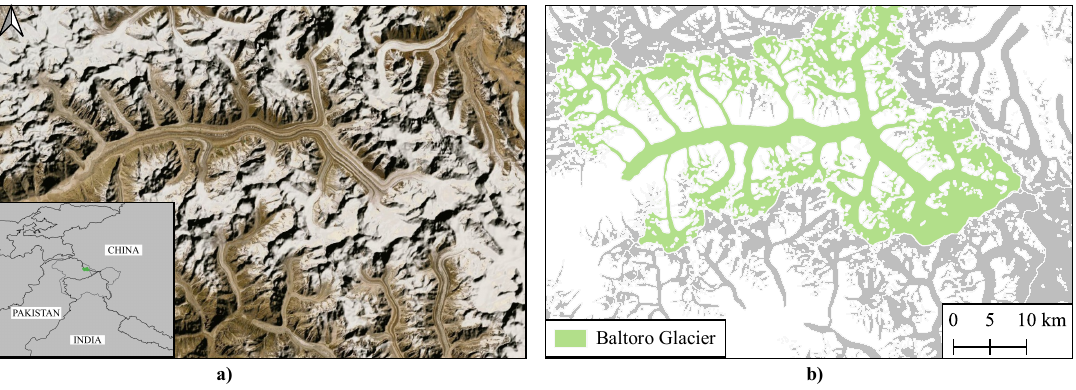
Figure 8. Baltoro glacier: ( a ) ESRI World Imagery, ( b ) glacier extent according to GAMDAM inventory. Table 3. Temporal variations in the area and number of supraglacial lakes on the Baltoro glacier. Supraglacial